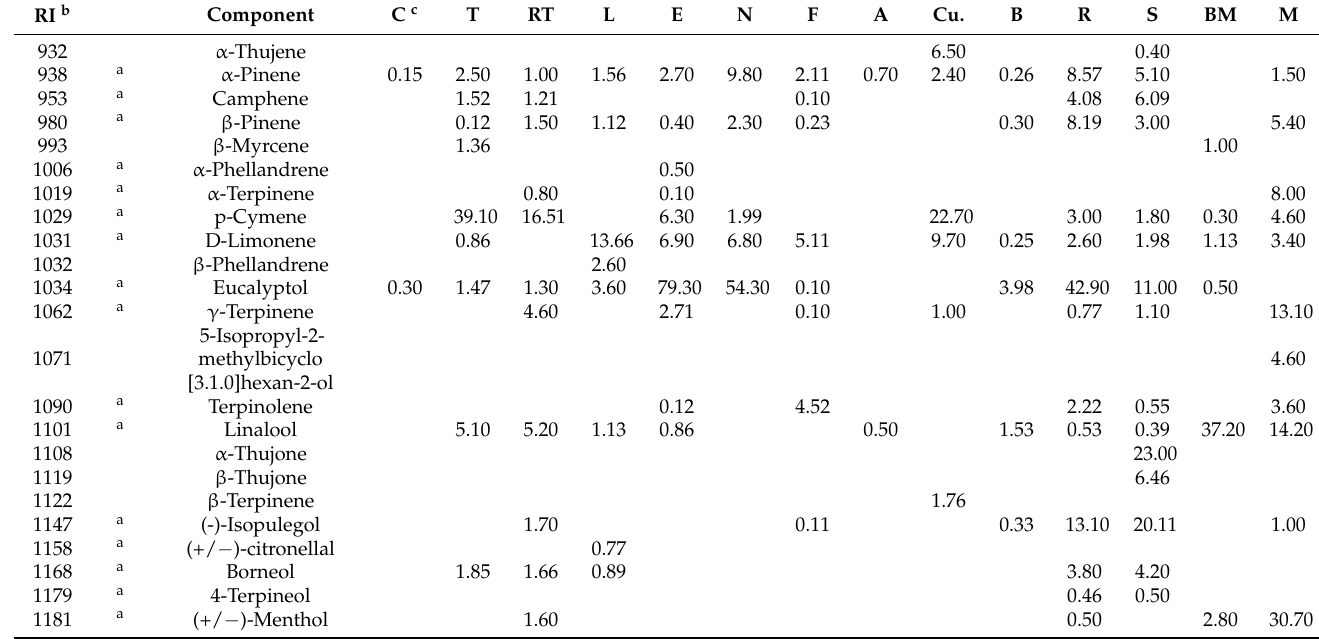
Table 3. The chemical composition and quantification of the major components in tested essential